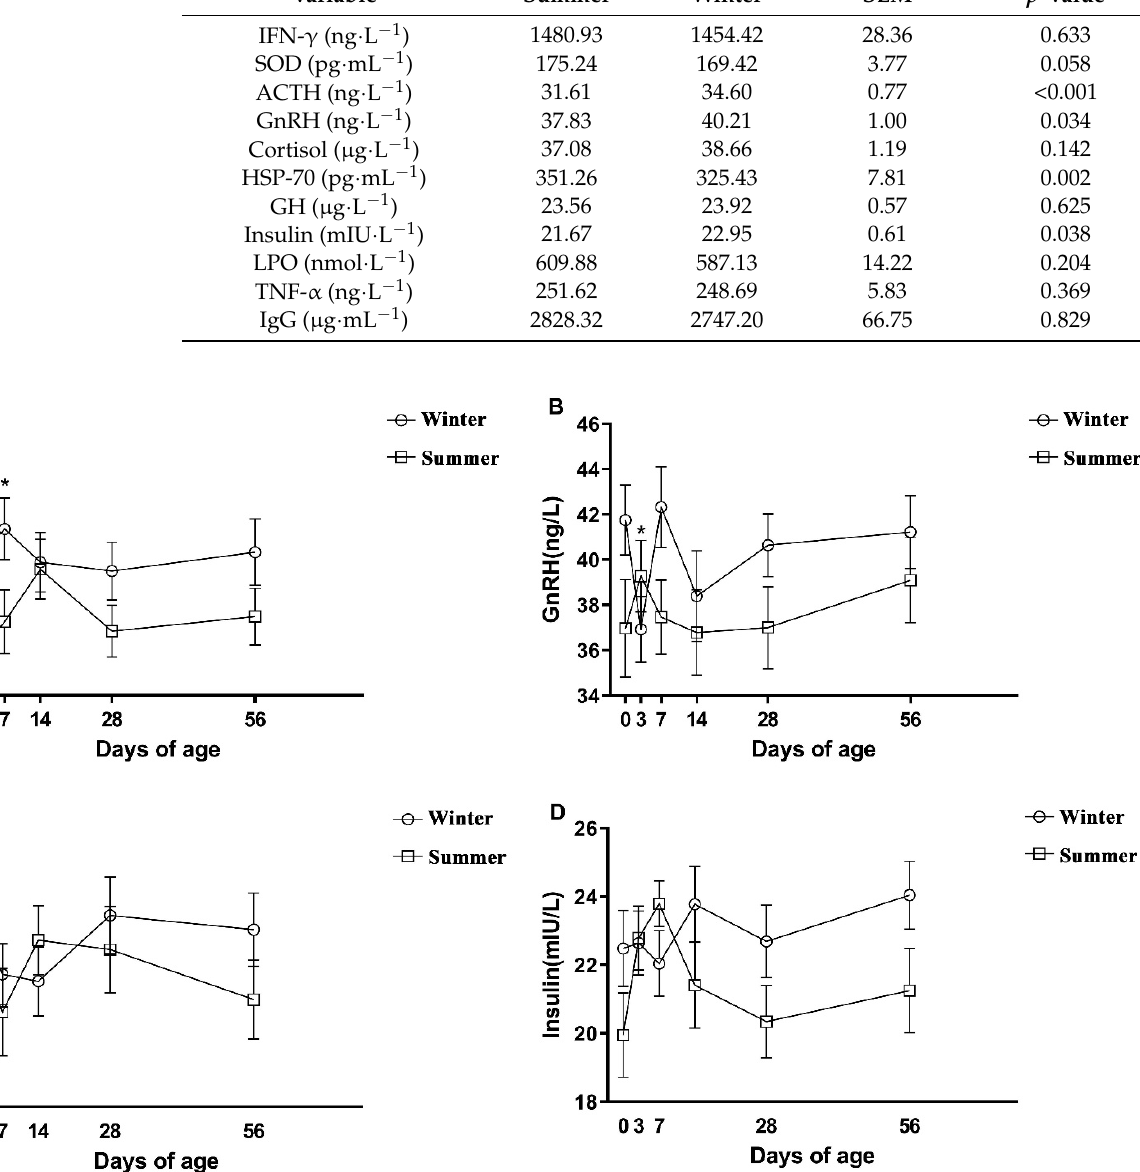
Figure 3. Seasonal heat stress in late gestation changes in plasma hormone concentrations at dif- ferent ages in calves. Including ( A ) ACTH concentration of plasma, ( B ) GnRH concentration of plasma, ( C ) cortisol concentration of plasma, ( D ) insulin concentration of plasma. Error bars represent SEM. Significance is indicated at p < 0.05 (*).